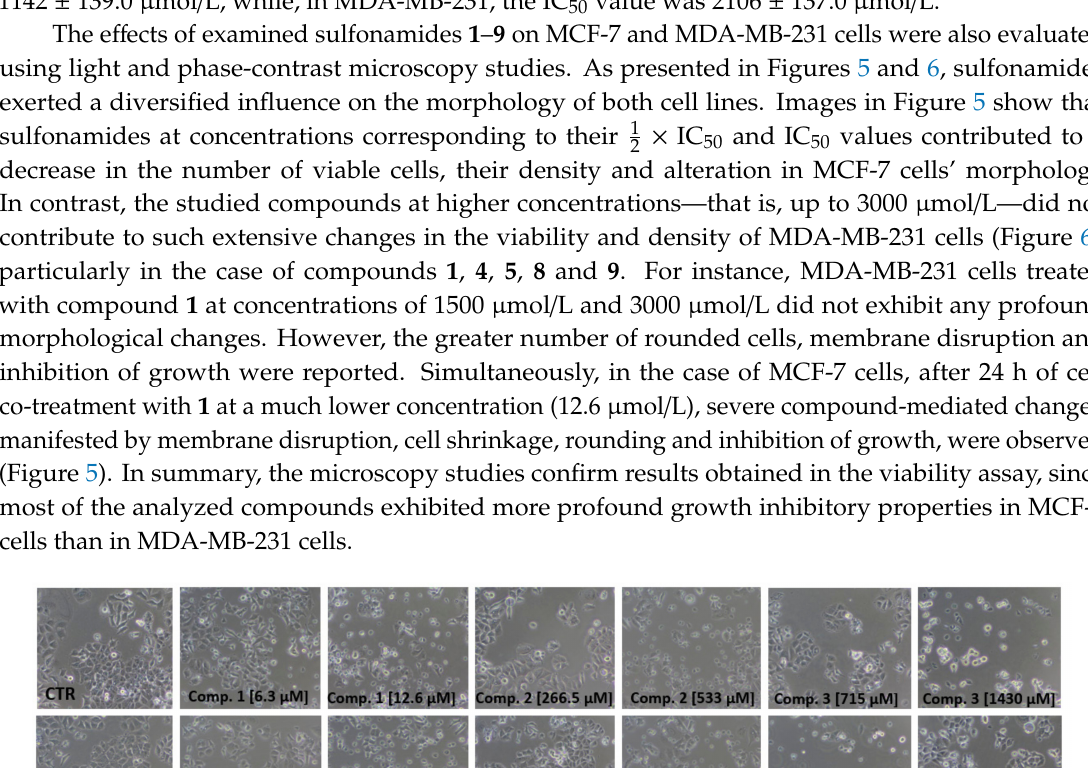
× IC µ mol / L) values on MCF-7 cells’ 50 and IC 50 ( 2